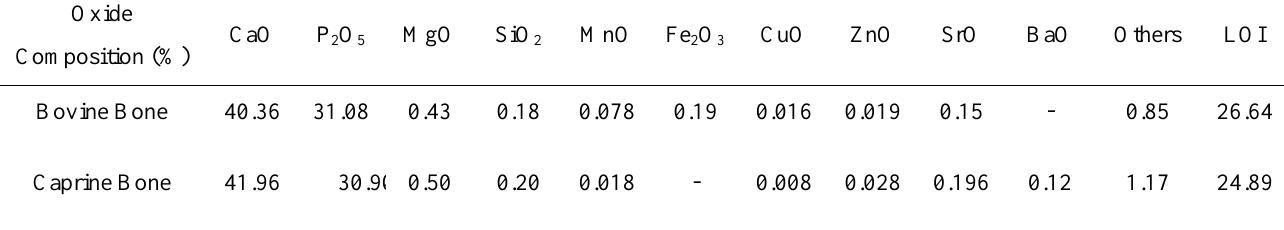
Table 1. Oxide composition (XRF analysis) of raw bovine and caprine bone